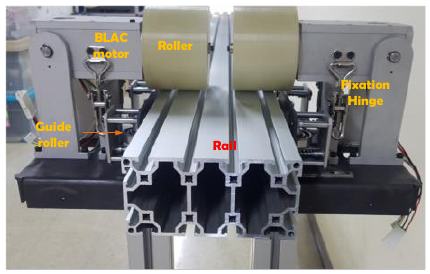
Figure 11. Manufactured rail mover.